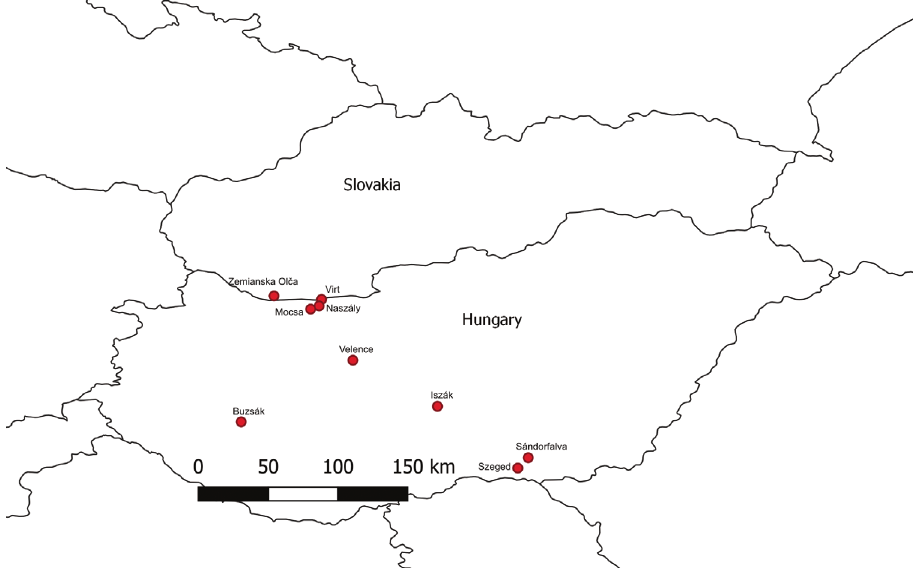
Figure 1. Map with localities of Pseudoanthidium tenellum in Slovakia and